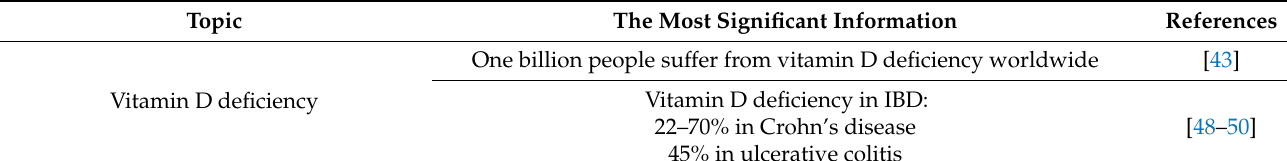
Table 2. The most significant information and studies presented in the